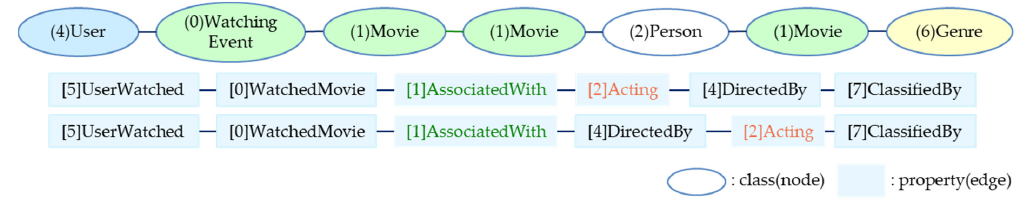
Figure 4. Simple paths in ontology graph.